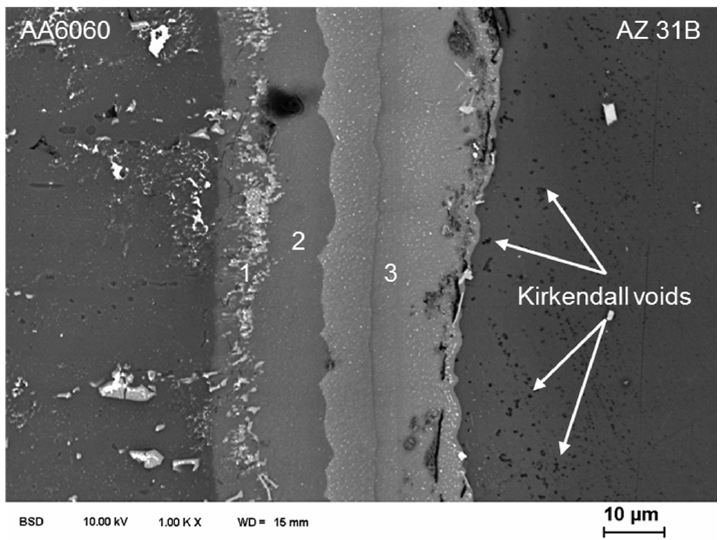
Figure 7. SEM image of the diffusion zone of an Al-Mg joint revealing ( 1 ) impurities of Al, Mg, Si and O 2 , ( 2 ) the Al-rich intermetallic phase Al 3 Mg 2 with ca. 1.5 at-% Ag and ( 3 ) the Mg-rich intermetallic phase Al 12 Mg 17 with ca. 3 at-% Ag.